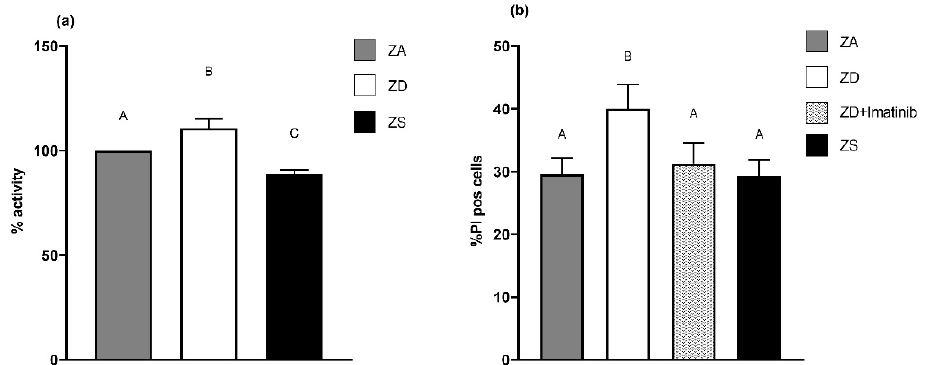
Figure 7. Zinc homeostasis affects the metabolic activity of A549 cells and their interaction with immune cells. Metabolic activity levels of zinc-adequate (ZA), zinc-deficient (ZD) and zinc- supplemented (ZS) cells were analyzed via MTT assay ( a ). Data for n = 10 independent experiments are shown as means + SEM. The amounts of PI-positive CD3 + cells from co-cultures with ZA-, ZD-, ZD+I (imatinib 0.1 µM)- and ZS-cultured A549 cells were determined by flow cytometry ( b ). Data for n = 17 independent experiments are presented as means + SEM. Statistical significances between data sets were calculated using one-way ANOVA and Tukey’s post hoc test ( p < 0.05). The same letter is never shared by statistically different data sets.